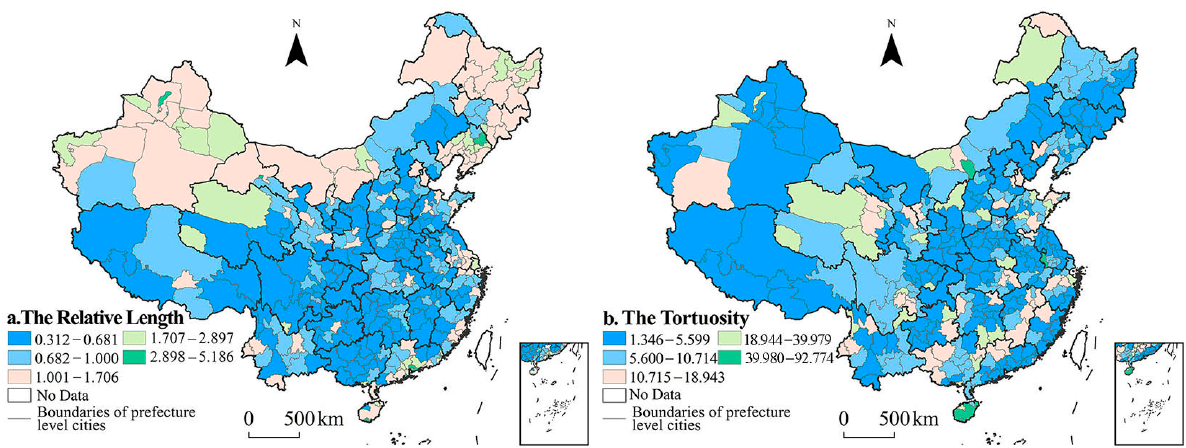
Figure 4. LISA time path of USI from 2000 to 2017 in China. Table 2. Spatiotemporal transition matrices of USI in China.